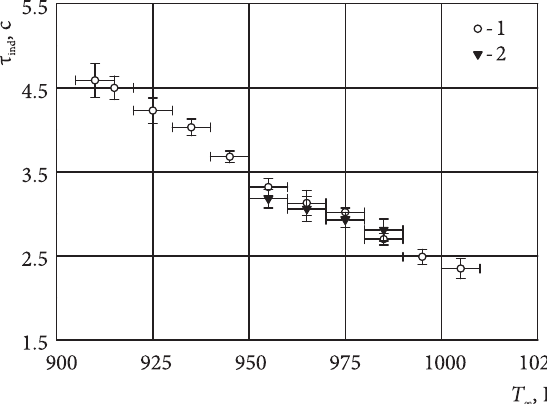
Fig. 6. Single droplet ignition delay time reliance on ambient temperature: 1 – diesel fuel (MD), 2 – three-component fuel blend (90 % MD+10 % RME+5 %